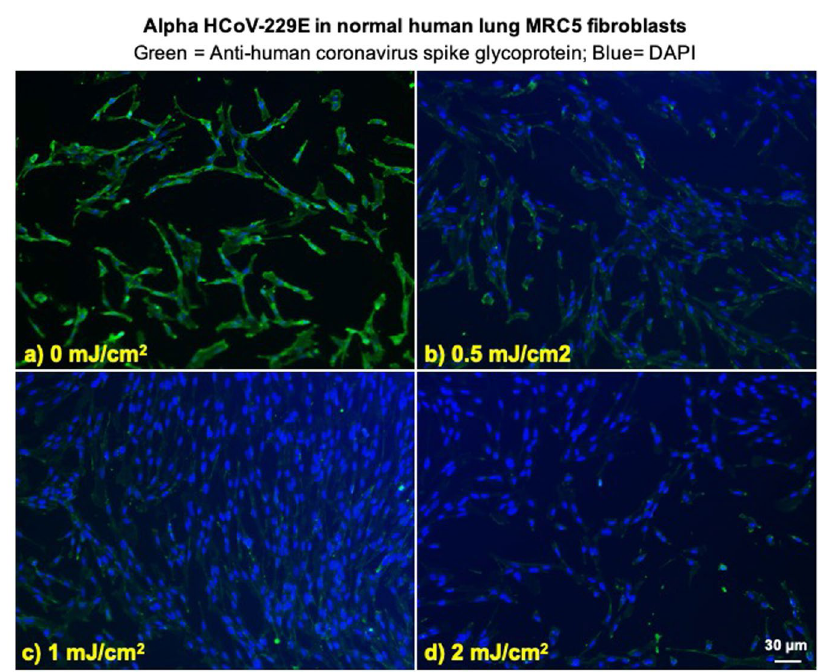
Figure 2. Infection of human lung cells from irradiated aerosolized alpha HCoV-229E as function of dose of far-UVC light. Representative fluorescent images of MRC-5 normal human lung fibroblasts infected with human alphacoronavirus 229E exposed in aerosolized form. The viral solution was collected from the BioSampler after running through the aerosol chamber while being exposed to ( a ) 0, ( b ) 0.5, ( c ) 1 or ( d ) 2 mJ/ cm 2 of 222-nm light. Green fluorescence qualitatively indicates infected cells (Green = Alexa Fluor-488 used as secondary antibody against anti-human coronavirus spike glycoprotein antibody; Blue = nuclear stain DAPI). Images were acquired with a 10× objective; the scale bar applies to all the panels in the